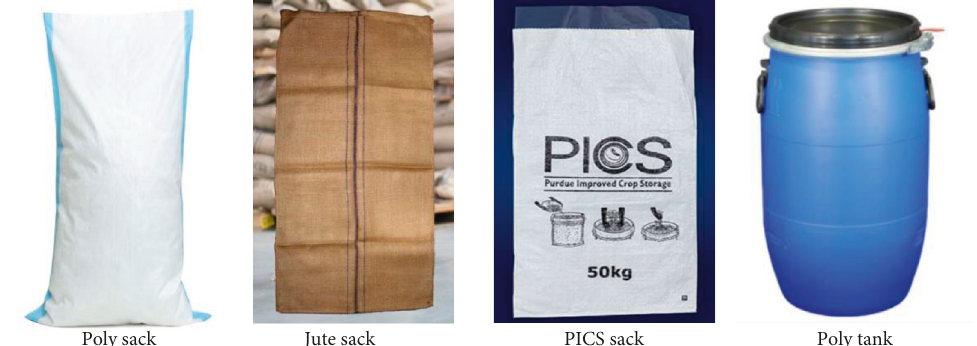
Figure 1: Pictures of the four storage